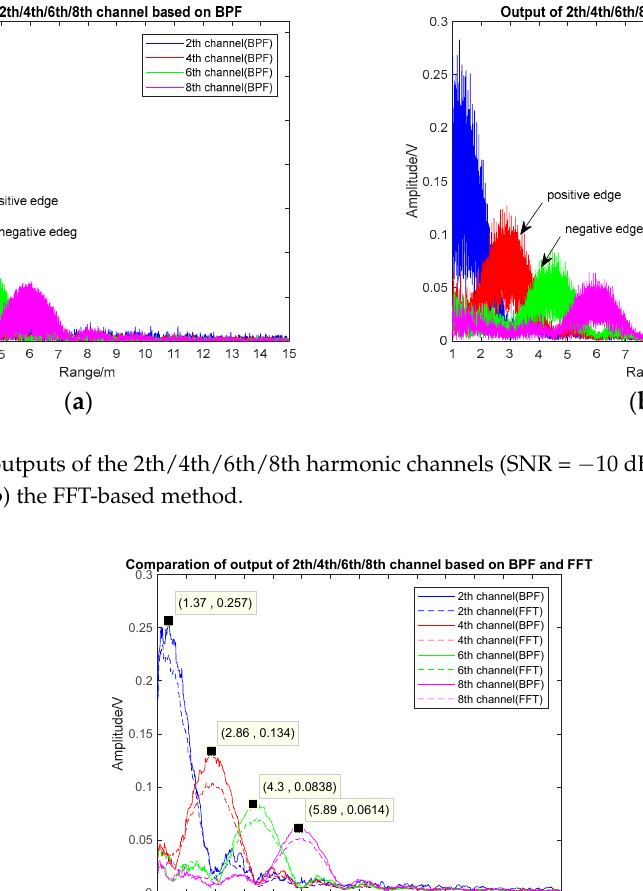
( b ) Figure 8. The designed anti-jamming sensor prototype . ( a ) The transceiver antenna and signal processing module, and ( b ) the RF module. The sub-parts of the RF module were designed using the sub-cavity to reduce the RF signal leakage, and signal processing was completed using the Field-Programmable Gate Array (FPGA). BPF- and FFT-based harmonic timing detection using three channels were implemented on the same hardware, and a comparison of the resources used is shown in Table 2. Table 2. Implementation complexity analysis (XC3S1000). Parameters Number of Slices Flip Flops